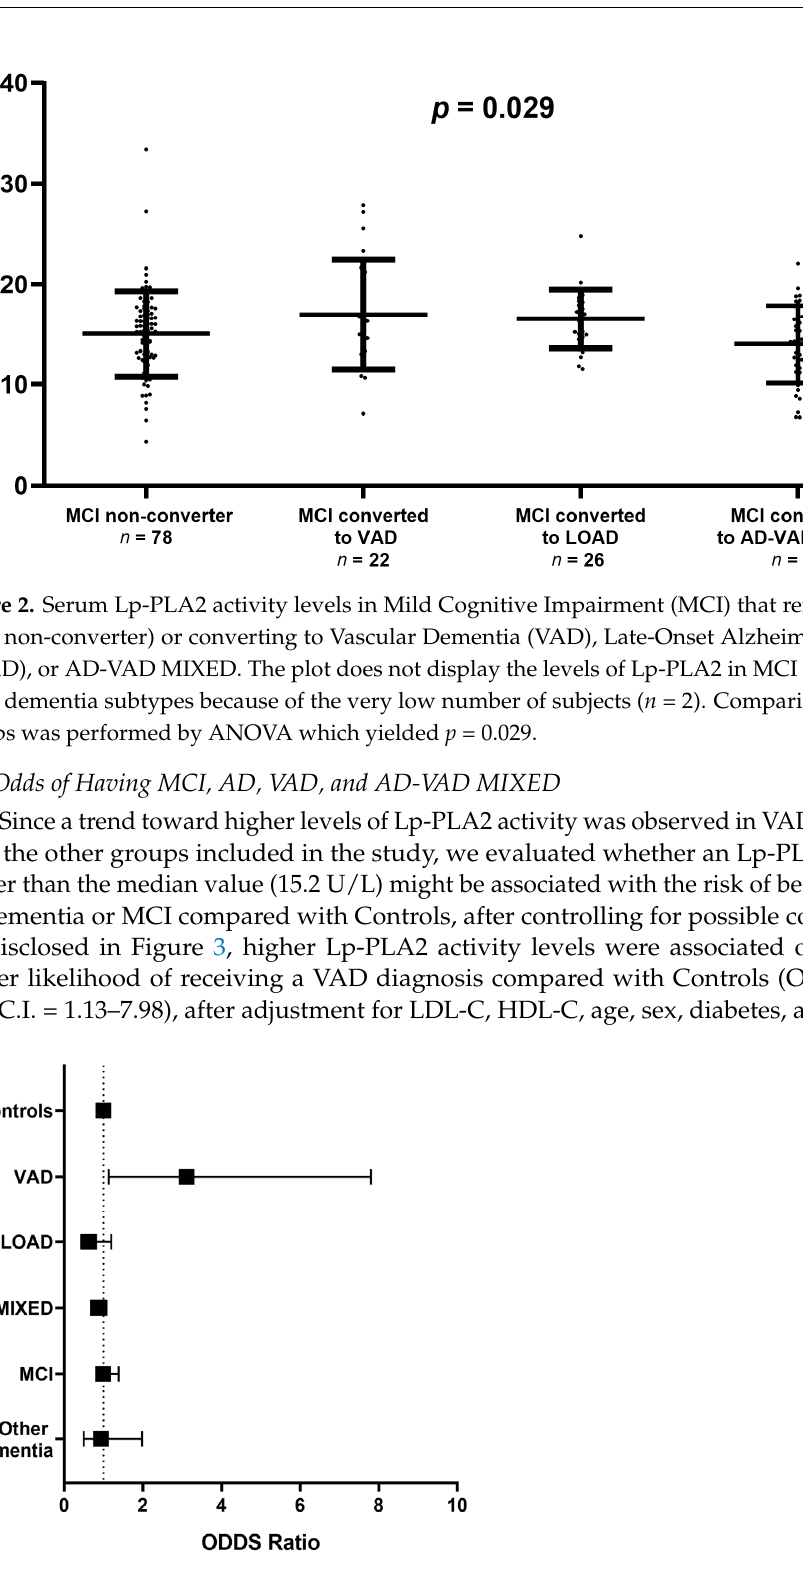
Figure 3. Adjusted odds ratios (95% C.I.) for diagnosis of Mild Cognitive Impairment (MCI), Late- Onset Alzheimer’s Disease (LOAD), Vascular Dementia (VAD), AD-VAD MIXED dementia, and other dementia subtypes compared with controls in individuals with high levels of Lp-PLA2 activity levels ( ≥ 15.2 U/L). Covariates: LDL-C, HDL-C, sex, age, diabetes, and CVD. The analysis was performed by multivariate logistic regression; significant OR for VAD diagnosis (O.R. = 3.115, 95% C.I. =